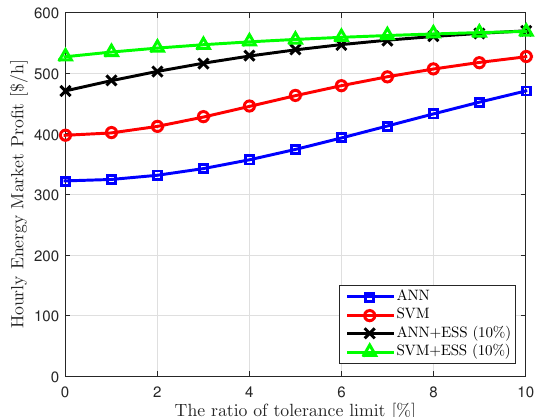
Figure 13. Hourly energy market profit with a penalty factor of 1.0.